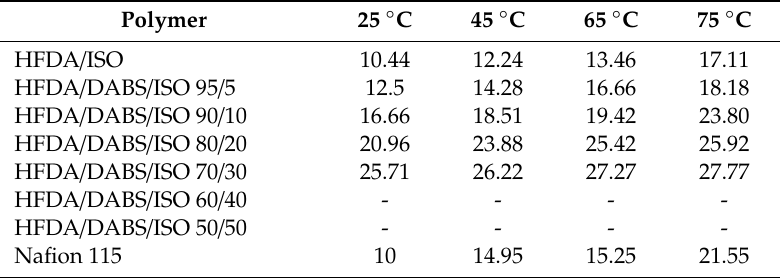
Table 3. Water absorption capacity (%) of HFDA / ISO and HFDA / DABS / ISO sulfonated copolyamides at di ff erent